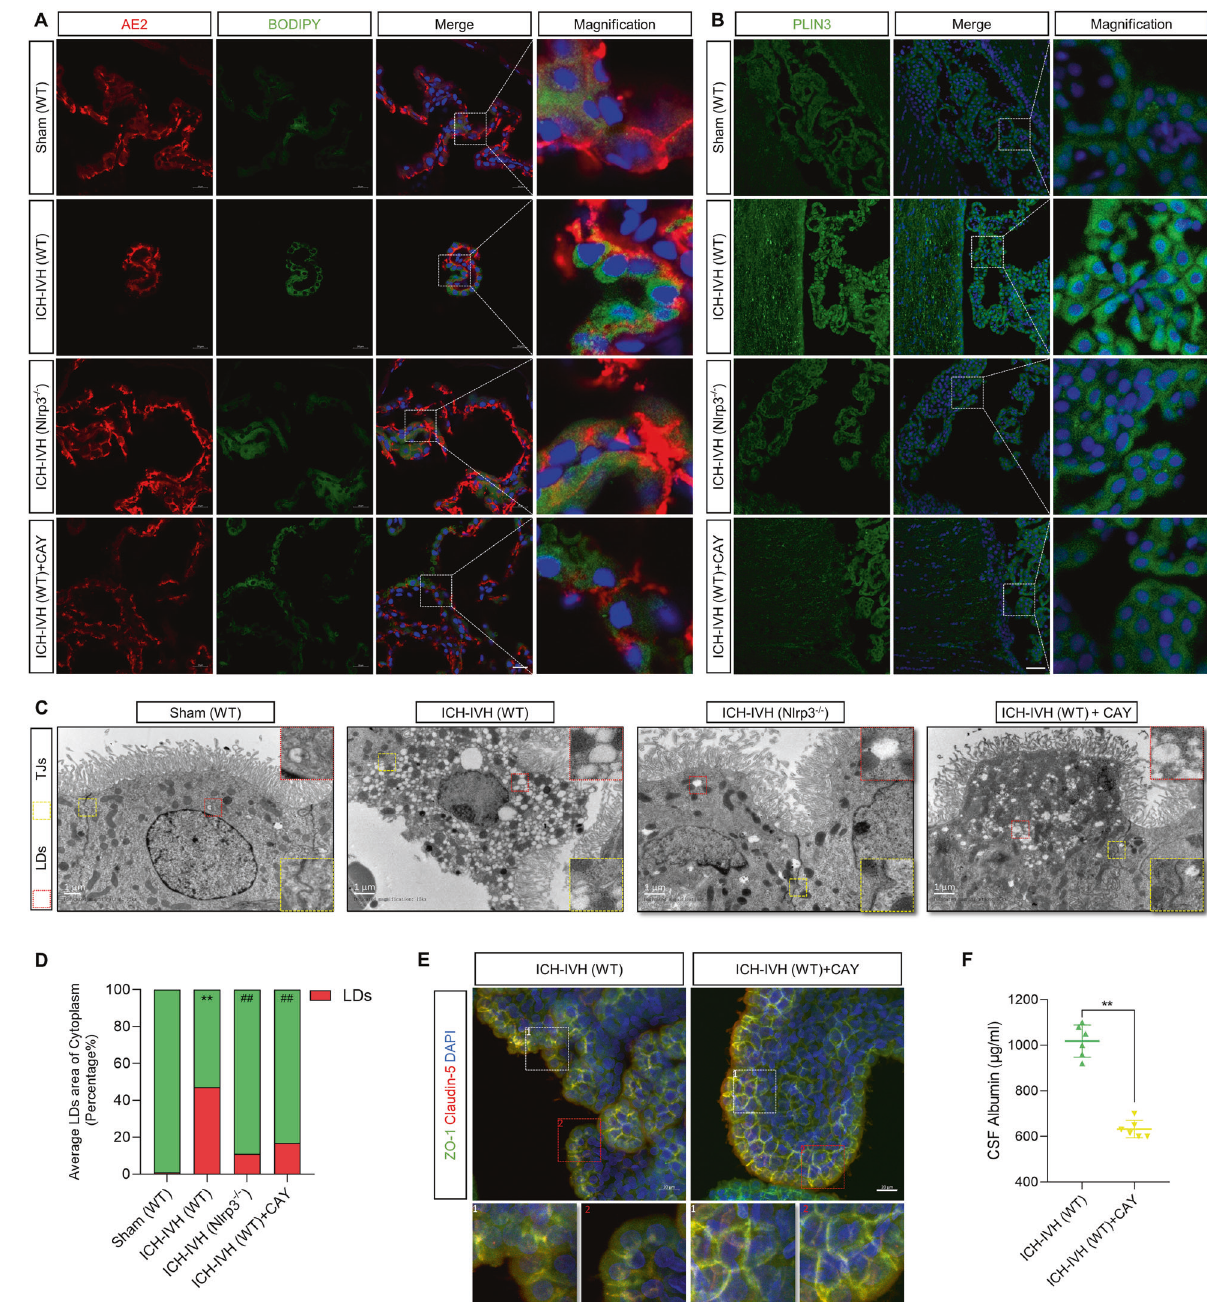
Fig. 5 Inhibiting LD formation improved B-CSFB permeability and neurological de fi cits after ICH-IVH. A BODIPY staining of LDs in the choroid plexus (marker with AE2). Scale bar = 20 μ m. B Representative images of PLIN3 staining indicating LDs in the choroid plexus. Scale bar = 50 μ m. C TEM images showed tight junctions and LDs in the choroid plexus. Scale bar = 1 μ m. D LD area percentage of total cytoplasm according to TEM images. ** P < 0.01, sham (WT) versus ICH-IVH (WT); ##P < 0.01, ICH-IVH (WT) versus others ( n = 3, one-way ANOVA). E Immuno fl uorescence staining of ZO-1 and claudin-5 in the choroid plexus after inhibiting LDs. Scale bar = 20 μ m. F CSF albumin content after ICH-IVH with or without CAY10650 treatment ( n = 6, unpaired t test). The results are expressed as the mean ± SD, ** P <